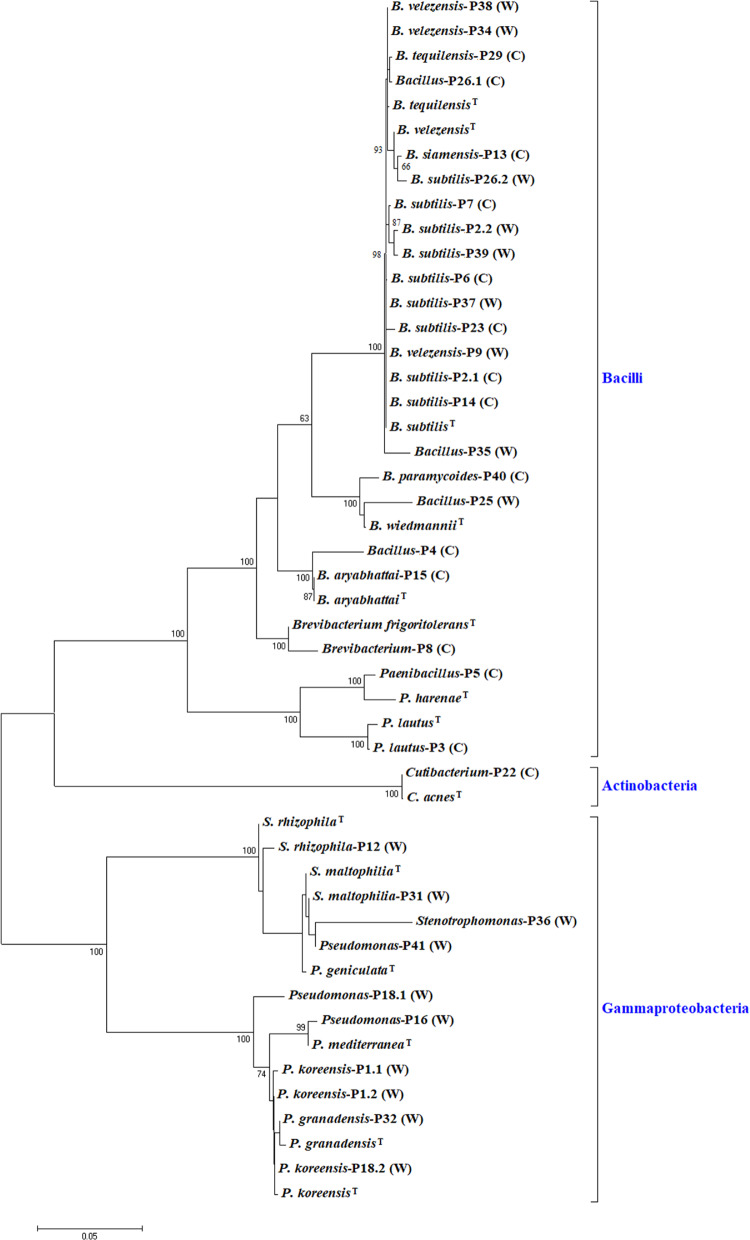
Phylogenetic tree based on nearly full length 16S rRNA gene sequences (1350 nt), of bacteria isolated from Echinocactus platyacanthus rhizosphere. The dendrogram was built with the Maximum Likelihood method and the Jukes-Cantor substitution model. The topology was tested by Bootstrap analysis using 1000 randomizations, only bootstrap values greater than 60% are shown.